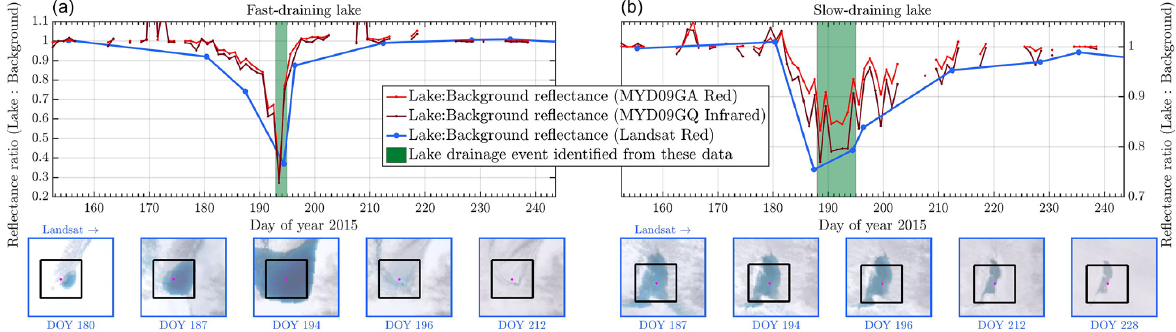
Figure 2. Illustration of lake drainage detection datasets on examples of (a) a fast-draining lake and (b) a slow-draining lake in the year 2015. We use the techniques of Selmes et al. (2011) to compare the red (MODIS, Landsat) and infrared (MODIS) reflections from a 1km × 1km box centered on each lake (black box in lower panels) to the 2km × 2km box surrounding each lake (lower panels). We identify the day of lake drainage as the date range when this reflectance ratio increases from its minimum value (green bar). This method allows us to qualitatively distinguish fast-lake-drainage events from slow events and to quantify the date of drainage, including an estimated